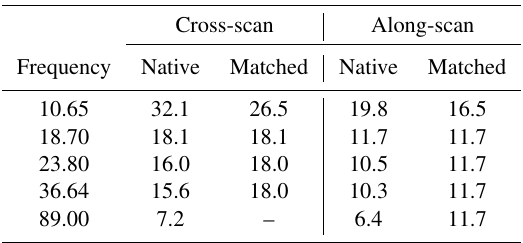
Table 3. Comparison of native and resolution-matched EFOV 3dB widths